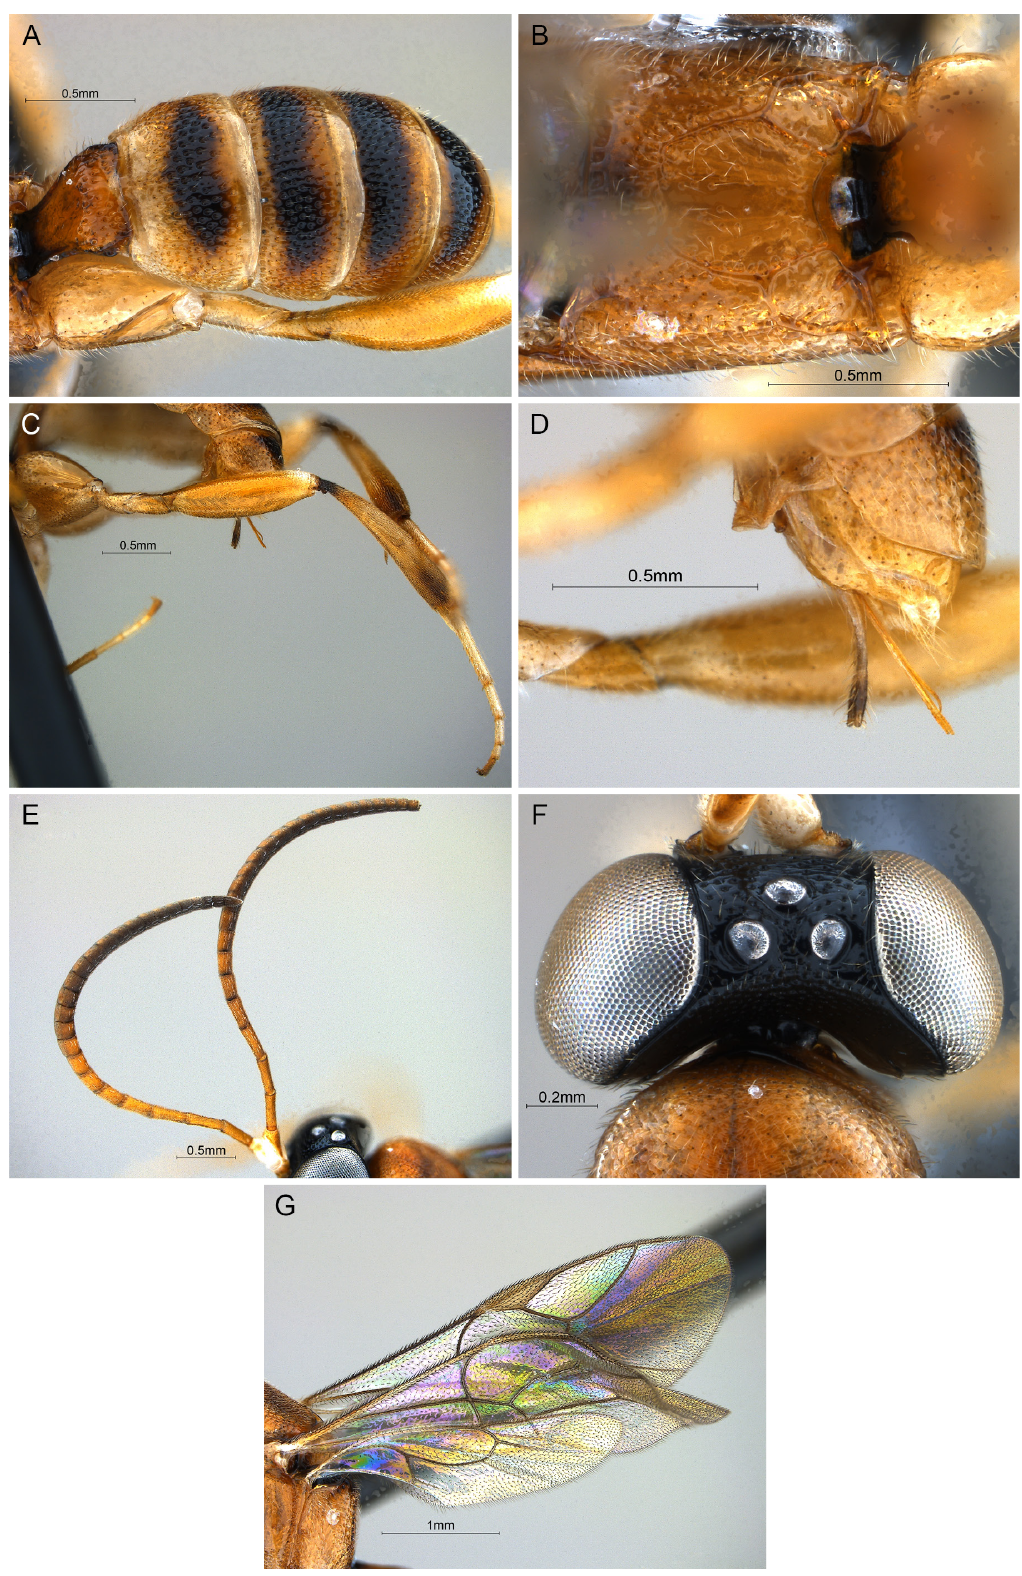
Fig. 14. Palpostilpnus pterodactylus sp. nov., paratype, ♀ (HKU). A . Metasoma, dorsal view. B . Propodeum, dorsal view. C . Hind leg. D . Ovipositor. E . Antennae. F . Vertex. G .